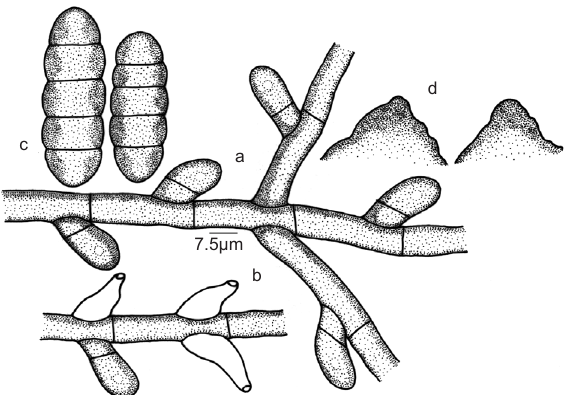
Figure 1. Asteridiella ixorae sp. nov. a - Appressorium; b - Phialide; c - Ascospores; d - Perithecial